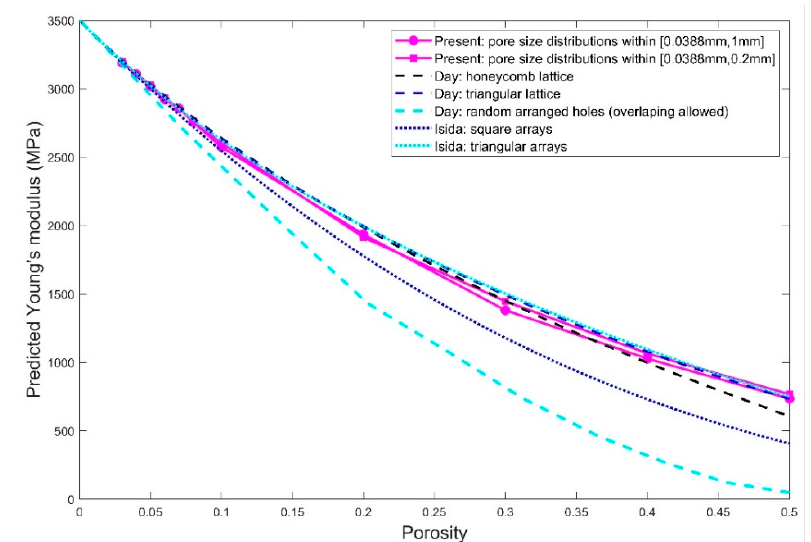
Figure 14. Predicted Young’s modulus against the porosity for the RVEs using both pore size distributions within [0.388 mm, 0.2 mm] and [0.388 mm, 1 mm]. Also included are the corresponding works from [35] and [36] abbreviated respectively as Isida and Day in the figure.